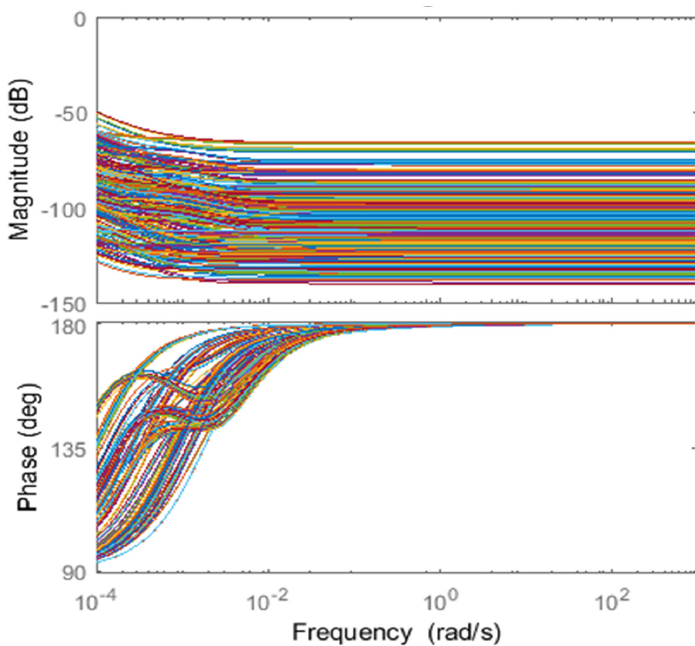
Figure 5. Tansfer function J sr ( s ) / I ch ( s ) frequency responses for the considered operating points